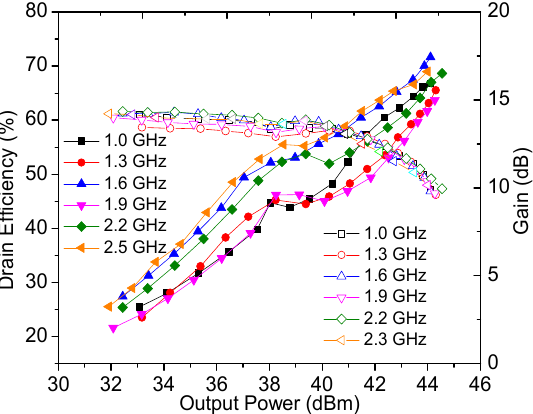
Figure 18. Simulated and measured performance at the saturation level.